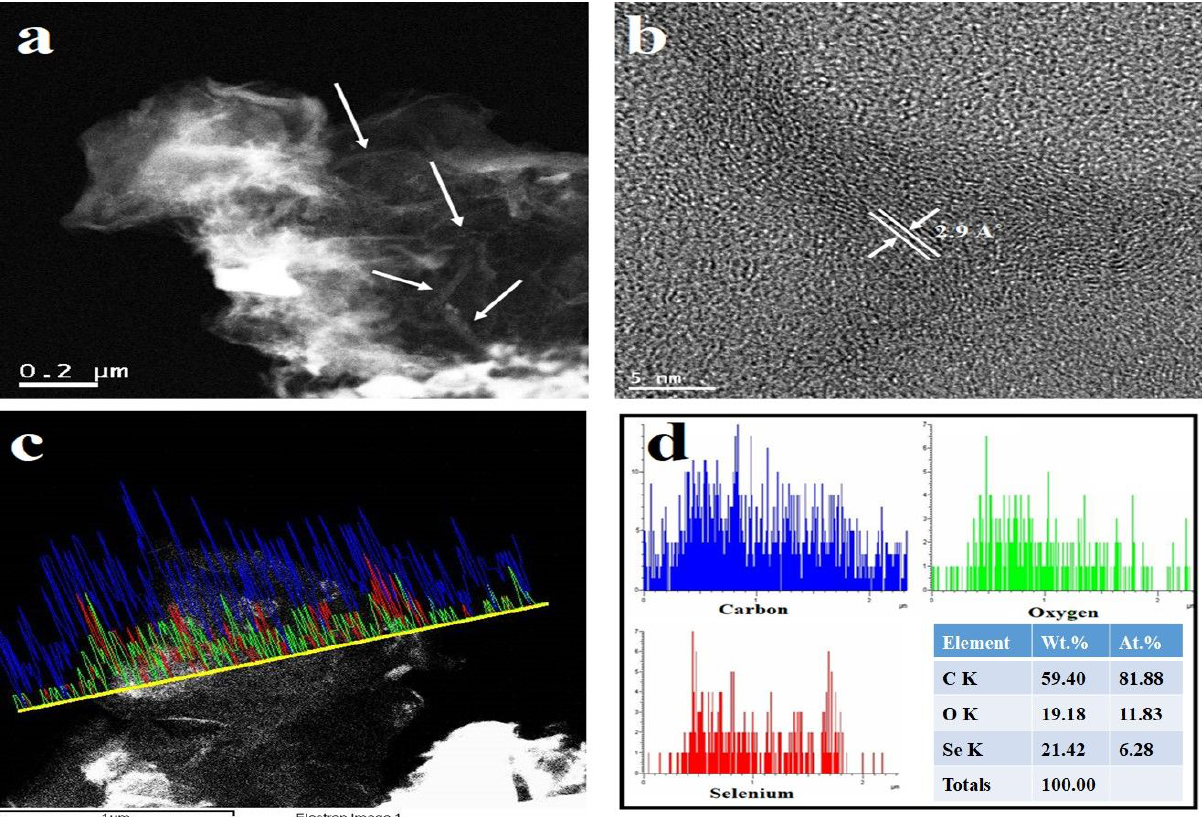
Figure 4: (a) TEM and (b) HR-TEM images, (c) Line EDS mapping and (d) corresponding concentration profile and elemental percentage of the synthesized Se-nanorods/rGO nanocomposite